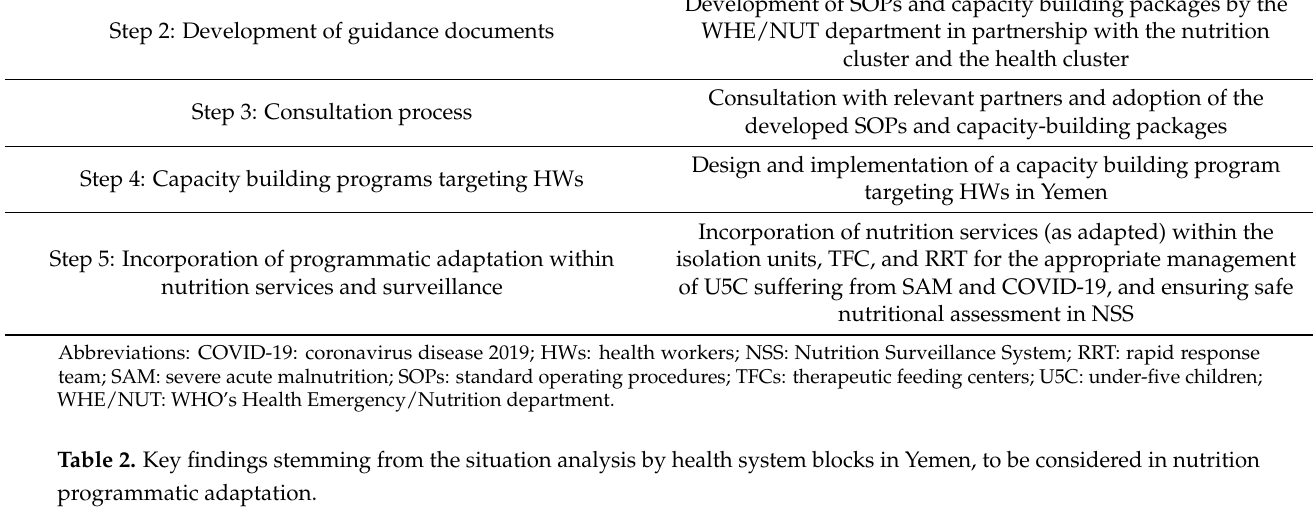
Description of Steps